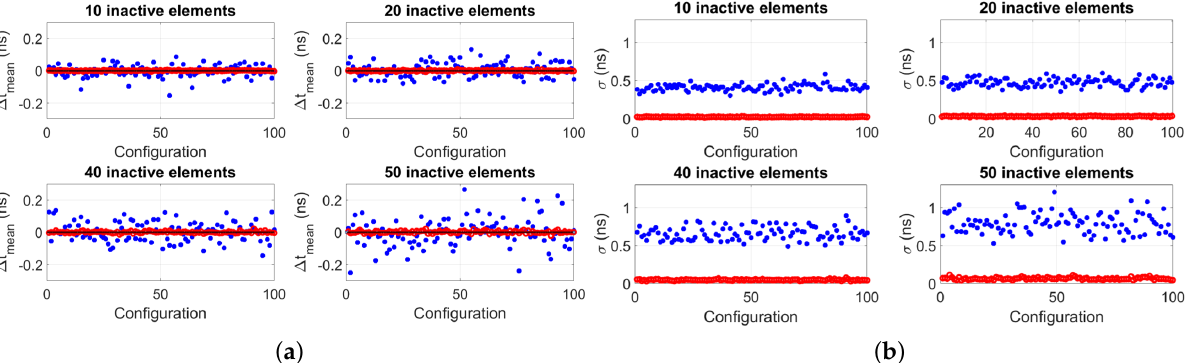
Figure 5. Simulation results of ( a ) mean transit time difference for 100 random configurations for the cases of a total of 10, 20, 40 and 50 inactive array elements situated at random locations along the aperture of 96 − elements arrays. Per configuration, a data point represents the mean of 50 “virtual” transit time difference values obtained from 50 simulated noisy wavefields. The blue dots represent the values obtained without implementing the proposed algorithm (i.e., after just beam- forming, obtaining and averaged signal per array and cross-correlating them to obtain the transit time difference), and the red circles represent the values obtained after implementing the proposed algorithm. The horizontal black line represents the value obtained without inactive elements, i.e., ∆ t ∆ t mean = − 0.93ps. ( b ) Standard deviation of the mean value of each configuration reported in ( a ). Each data point represents the standard deviation of 50 “virtual” transit time difference values obtained per configuration.